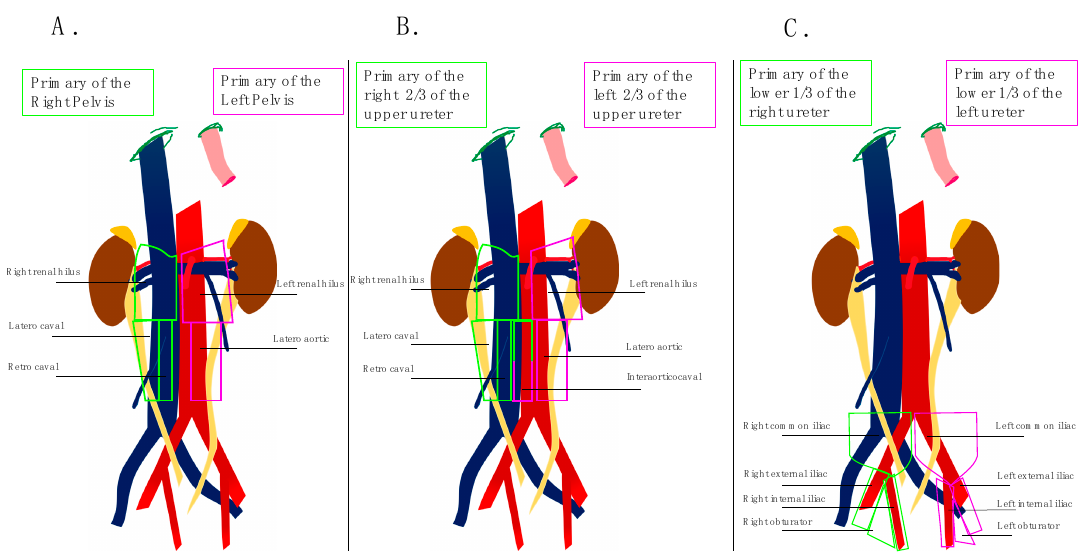
Figure 2. Lymph nodes anatomical templates based on primary tumors. ( A ) Primary tumor of the renal pelvis; ( B ) Primary tumor of the 2/3 of the upper ureter; ( C ) Primary tumor of the lower 1/3 of the ureter.